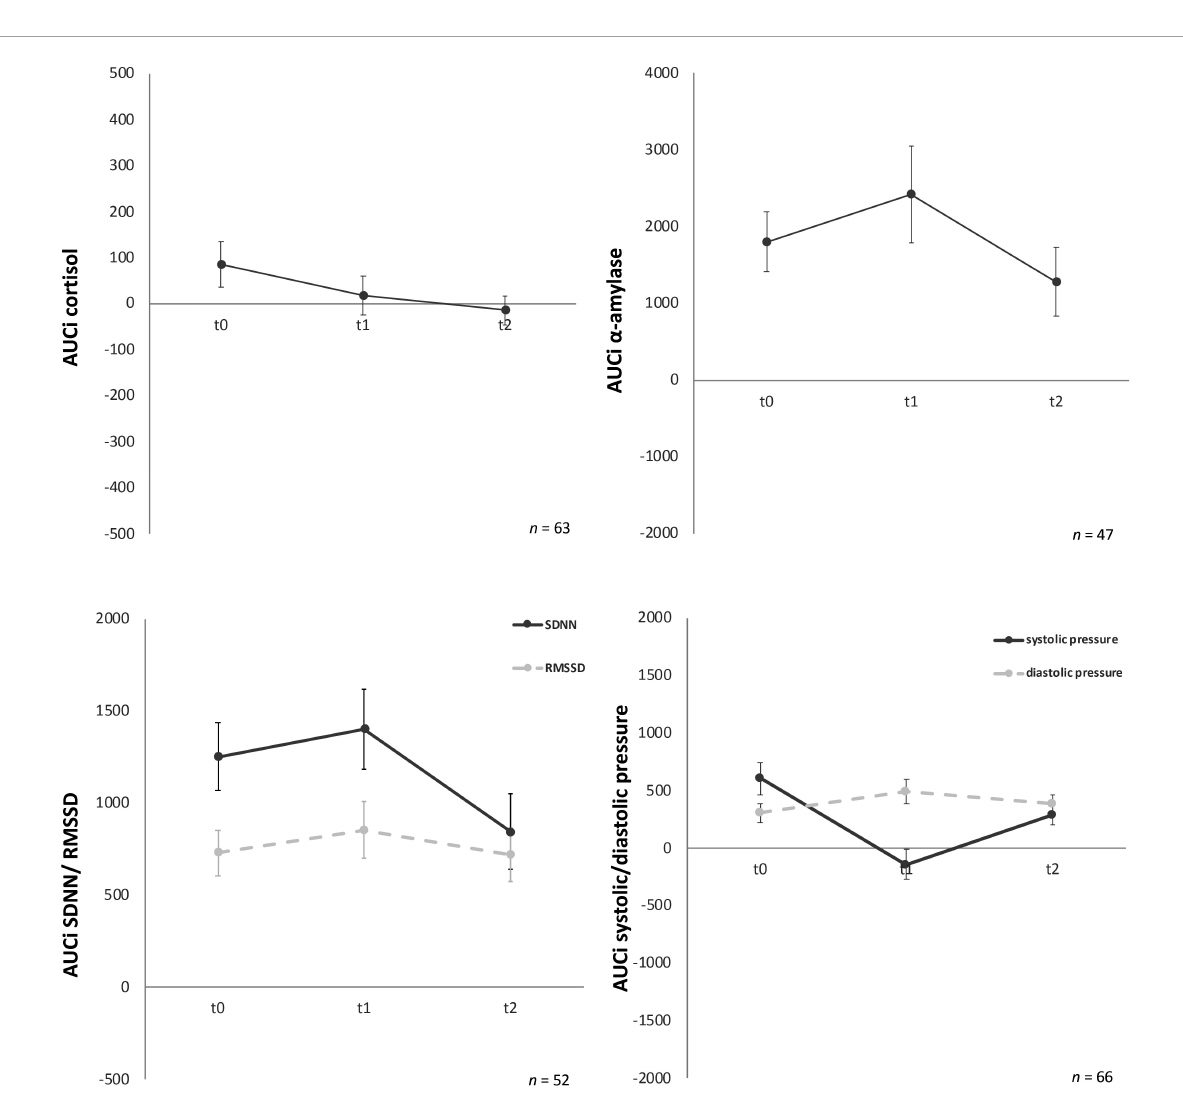
changes in the groups with/without mission abroad within the TSST-G experiments for men. Exemplary results can be found in Figure 2 . For cortisol, heart rate, RMSSD and systolic pressure with TSST-G t0, t1, and t2, the mixed ANOVA revealed non- significant results for all group and time x group effects. Most time effects were significant with p < 0.001 ( Table 2